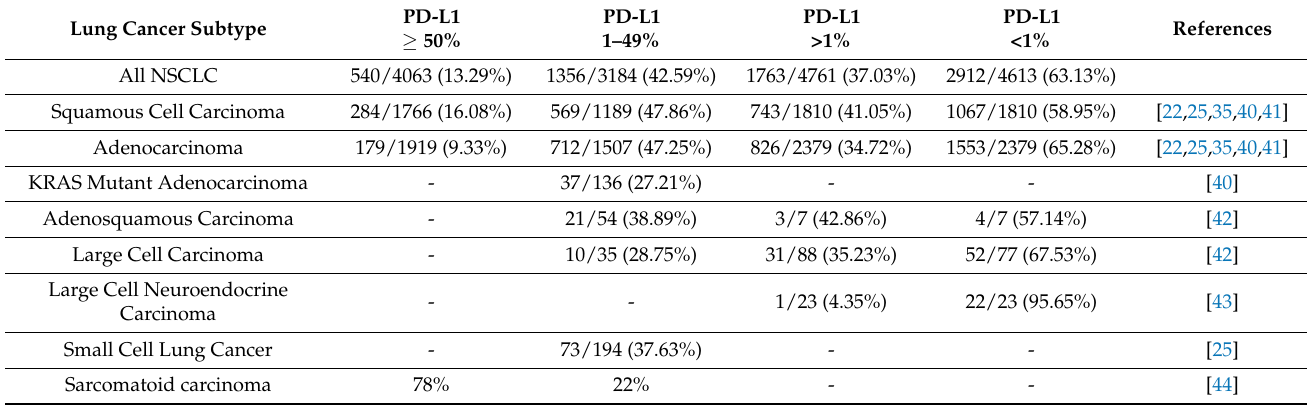
Table 1. PD-L1 expression in subtypes of lung